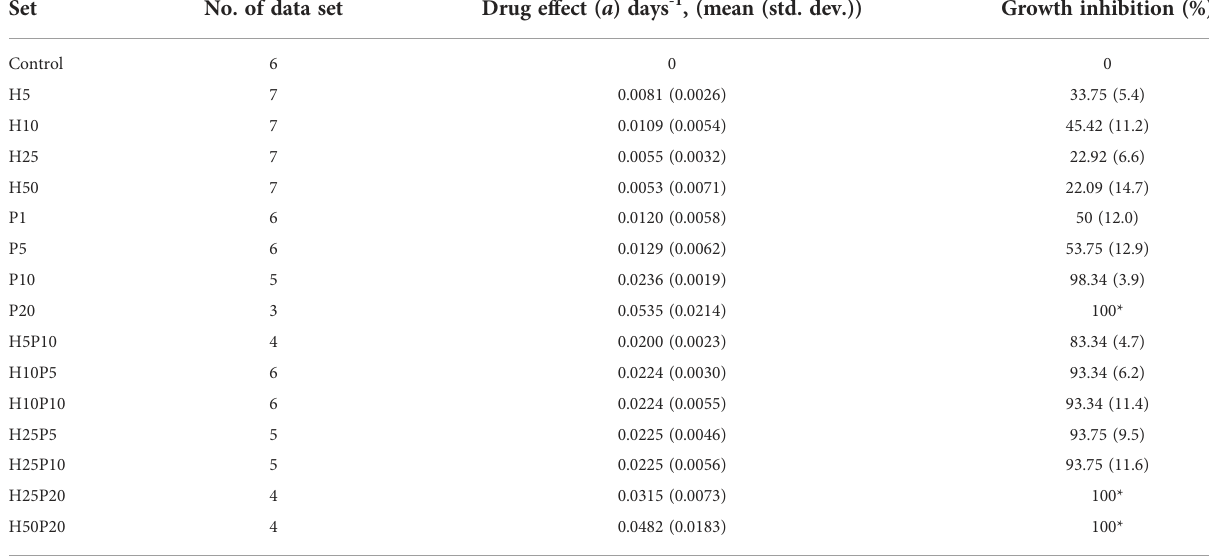
Thedrugeffectparameteraisestimatedusingmodel(4)by fi xingk=1e6µm2,A0=200µm2,andthegrowthrateofthecontrolissetasr=0.0240(0.0042).Theoverallgrowthrateoftreated coloniesisrtreat=r-aandgrowthinhibitioniscalculated as%GI=(1-(rtreat/r))×100.*NotethatwhilecalculatingGIvalueforP20,H25P20,H50P20,asvalueofr<a,r-abecomesnegative resulting in %GI>100, which is rounded off to